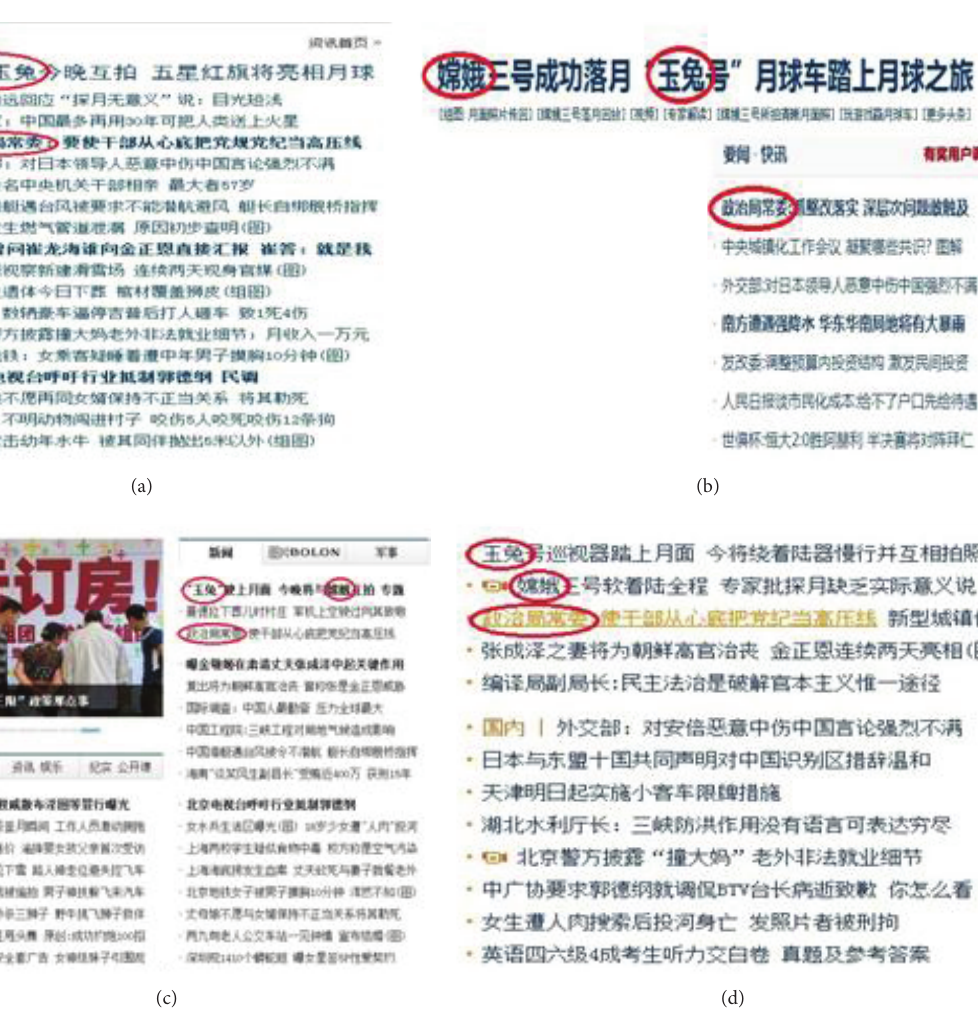
Figure 1: (a) News headline in http://www.ifeng.com/, (b) news headline in http://www.163.com/, (c) news headline in http://www.people .com.cn/, and (d) news headline in